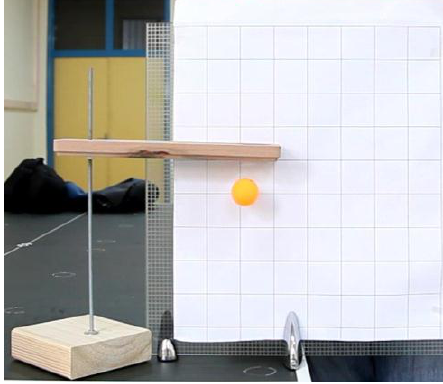
Figure 6. The Camera that was used